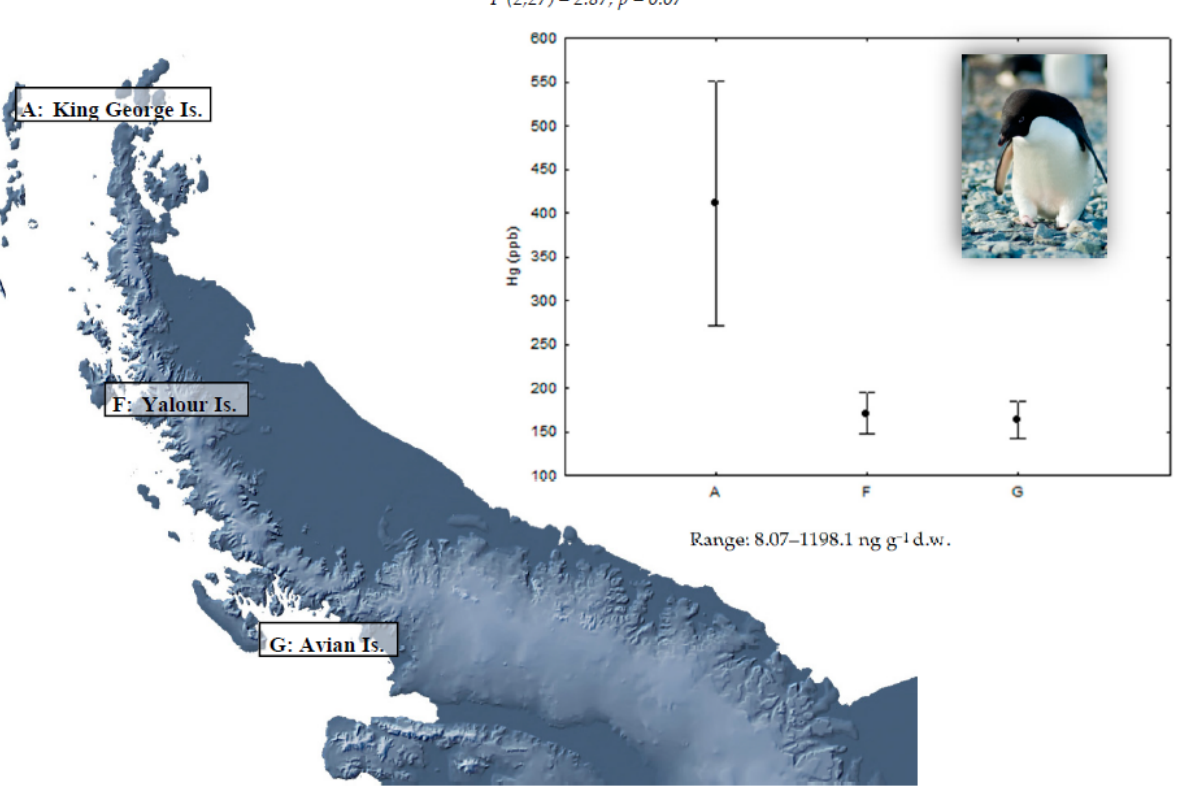
Figure 3. Mean (±SE) Hg concentration in feathers of Adélie penguins ( P. adeliae ) in three locations of the Antarctic Penin- Figure 3. Mean ( ± SE) Hg concentration in feathers of Ad é lie penguins ( P. adeliae ) in three locations of the Antarctic Peninsula sula area. For sample sizes, see Table 1. area. For sample sizes, see Table